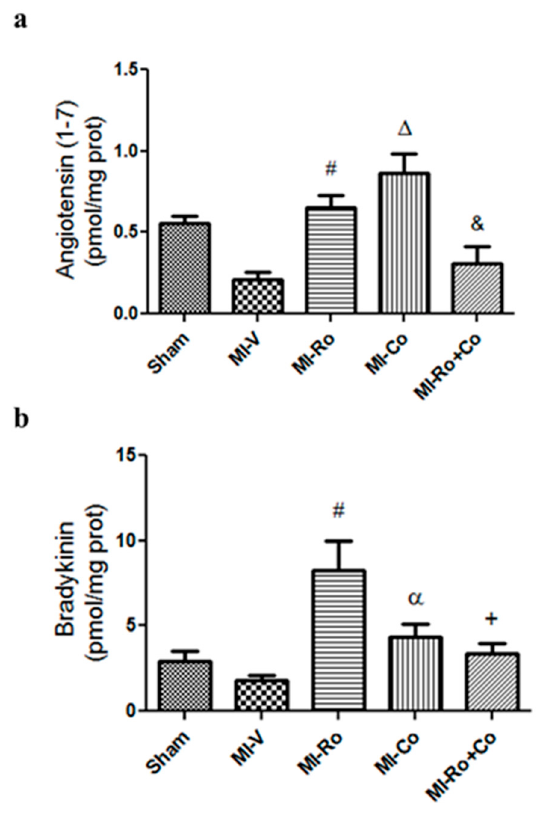
Figure 6. The effect of extarcts from Rosmarinus officinalis ( Ro ), Crataegus oxyacantha ( Co ), and their combination ( Ro+Co ) on vasorelaxing components concentration. Angiotensin-(1–7) ( a ) and bradykinin ( b ) were quantified in the myocardial ischemic areas from sham, myocardial infarction (MI)-vehicle treated (MI-V), MI- Ro , MI- Co , and MI- Ro+Co . The values correspond to the mean ± SEM of six different experiments. p < 0.05 ANOVA one way post Tukey # MI-V vs. MI- Ro , Δ MI-V vs. MI- Co , + MI- Ro vs. MI- Ro+Co , α MI- Ro vs. MI- Co , & MI- Co vs. MI- Ro+Co .